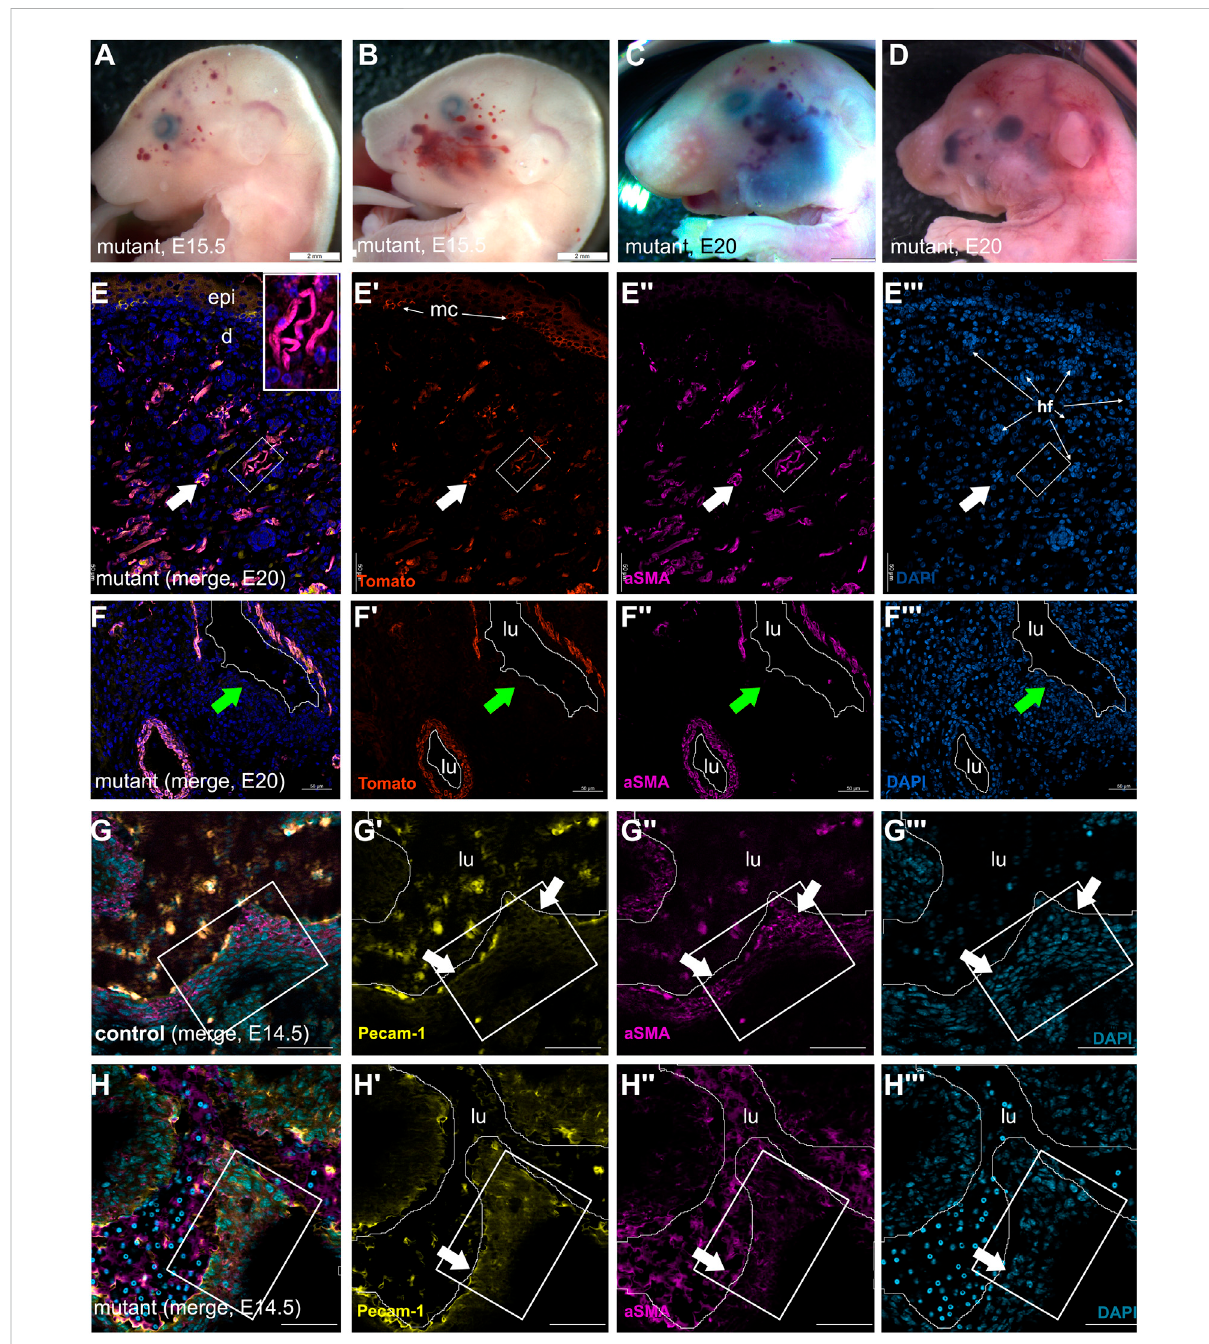
Vascular lesions are present before birth with disorganized smooth muscle or connective elements in Wnt1-Cre ; Pik3ca H1047R/+ mutants. (A) MutantembryoatE15.5withperiocularvascularanomalies. (B) Mutantlittermateof(A)withsegmental vascular anomaliesinthemaxillaryregion. (C, D) Mutant E20 fetuses of distinct litters. (C) was dead in utero and had a vascular lesion on the mandible. All show maxillary and posterior periocular vascular anomalies and megalencephaly. Scale bars A-D, 2 mm. (E) Facial skin of E20.5 mutant fetus with numerous double-labeled, small capillary anomalies in upper dermis (arrow, boxed region enlarged in inset) around hair follicles. (E,F) : Tomato fl uorescent protein (E 9 ,F 9 ) : smooth musclemarker, α -smoothmuscleactin(aSMA); (E 99 ,F 9999 ) nuclearmarkerDAPIinblue (E 999 ,F 999 ) .BarsE,F=50 μ m. (F) Cellularorganizationaroundan intracardiac vascular anomaly at E20.5, showing a discontinuous (arrow) smooth muscle layer of mutant NC origin in a distinct litter from the ones representedinC,D,littermateofE. (G) Controllittermateand (H) mutantpulmonary trunk;mergedimmuno fl uorescence; ( G 9 ,H 9 yellow, endothelial marker Pecam-1 (CD31), (G 99 ,H 99 ) purple, smooth muscle marker, α -smooth muscle actin (aSMA) (G - ,H - ) blue, nuclear marker DAPI. Despite maintenanceofendothelium(arrows, G 9 ,H 9 )inthemutantgreatartery,boxedareasindicatedisruptionofthelaminarsmoothmuscleorganizationof the vascular wall at E14.5. Bars G,H = 50 μ